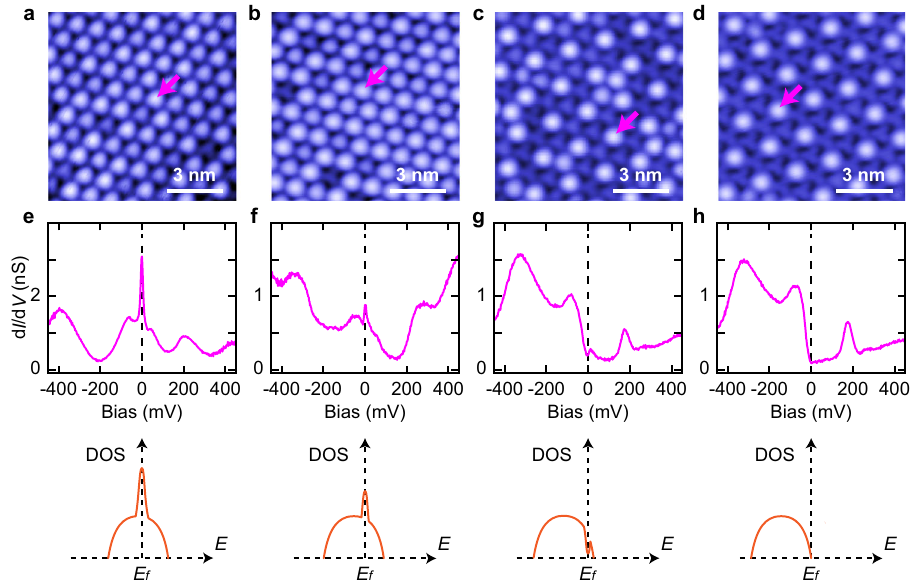
Fig. 4 Evolution of the Kondo resonance peak. a – d Constant-current STM topographies taken on the Type-II 1 T -TaS 2 surface as increasing the intercalant concentration of Pb ( V s = − 500 mV, I = 20 pA). e – h Top panels: d I /d V spectra taken on the purple arrows shown in a – d , respectively. Bottom panels: schematics showing the evolution of the narrow electronic band and Kondo resonance peak shown in the top panels. The data shown in this fi gure are taken at T = 4.3 K. Source data are provided as a Source Data fi